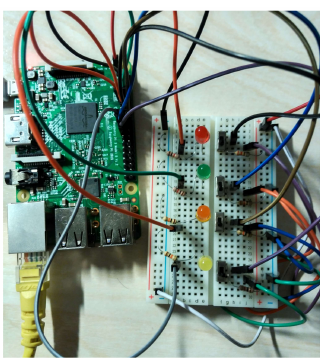
Figure 7. Final circuit for the simulation of a bottle collecting robot using a TR node.